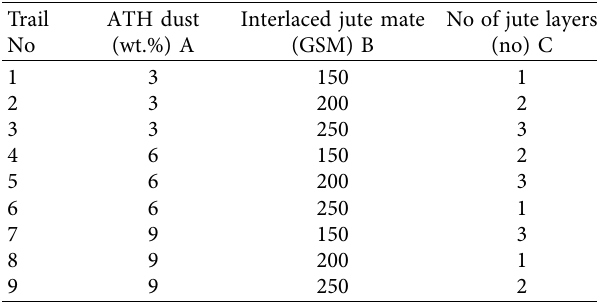
Table 2: L 9 immaterial design of mixed